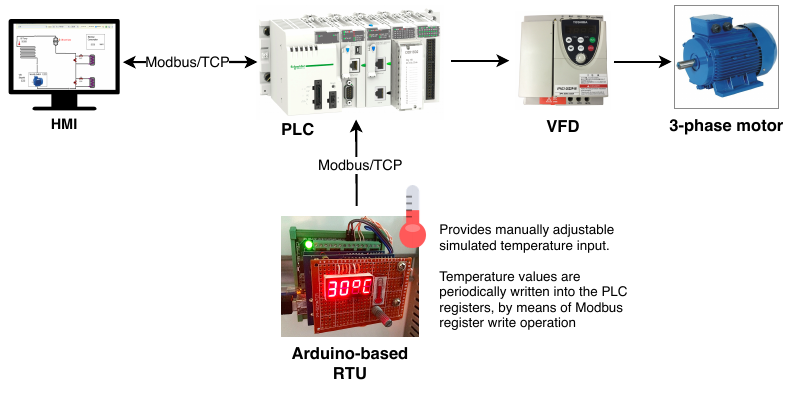
Figure 4. Testbed topology.